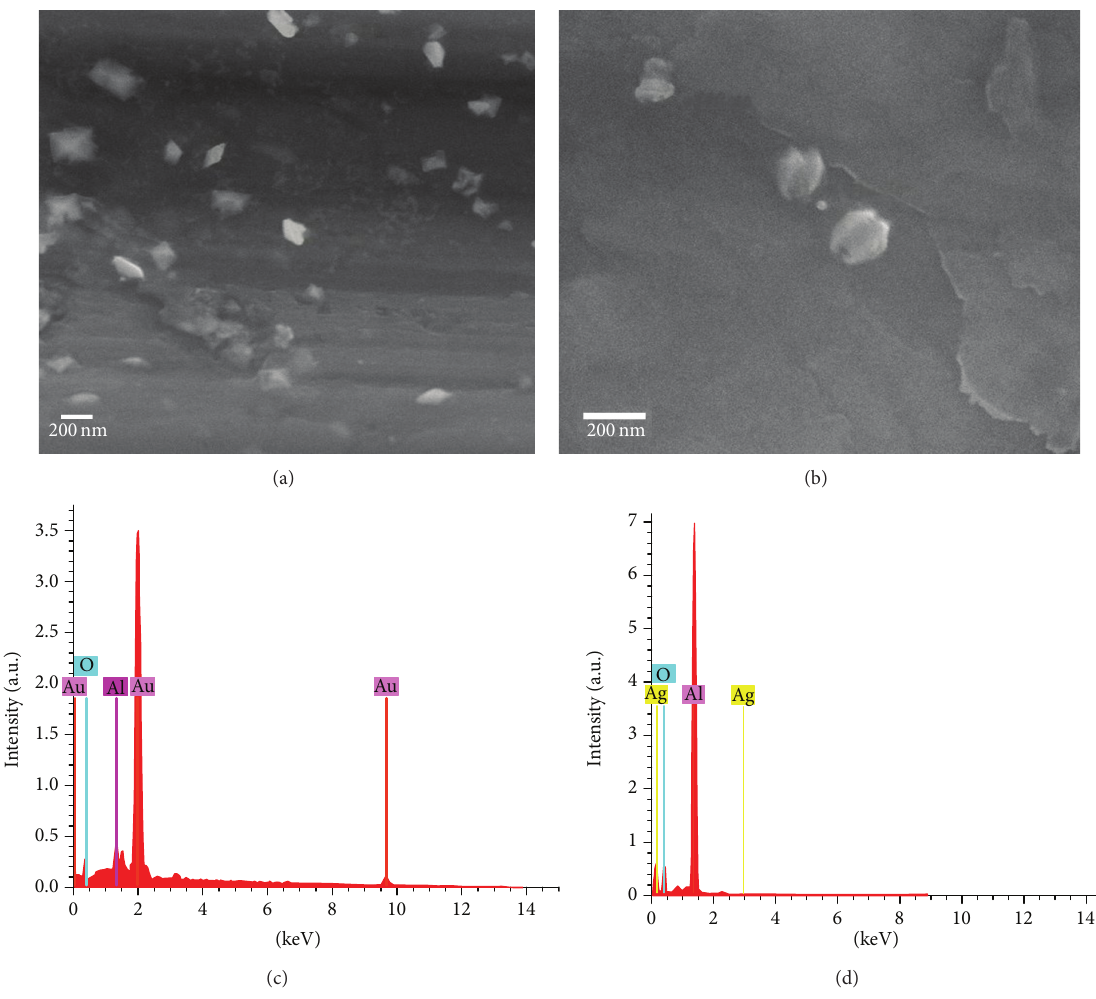
Figure 5: (a) SEM micrographs of gold nanoparticles. (b) SEM micrographs of silver nanoparticles. (c) EDX spectrum of gold nanoparticles. (d) EDX spectrum of silver